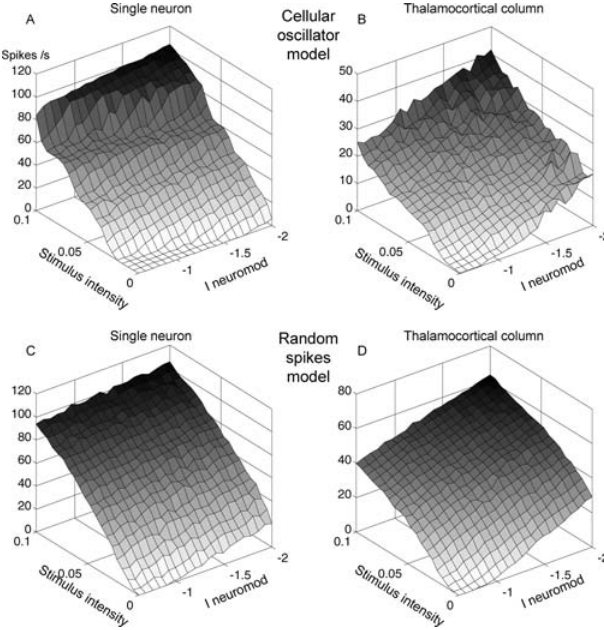
Figure 3. Combination of Intrinsic and External Activity in the Firing Rate of a Single Neuron or a Thalamocortical Column Simulations examined the joint effects of a variable external input (left axis [stimulus intensity], parameter g input , expressed in mS/cm 2 ) and a variable neuromodulatory current that modified spontaneous activity and neuronal responsiveness (right axis [ I neuromodul ], ex- pressed in l A/cm 2 ). We simulated a single neuron (A and C) or a thalamocortical column (B and D), either with the cellular oscillator model (A and B) or with the random spikes model (C and D). In each case, we monitored the mean number of spikes emitted by pyramidal neurons during a 500-ms duration input. DOI: 10.1371/journal.pbio.0030141.g003 PLoS Biology |